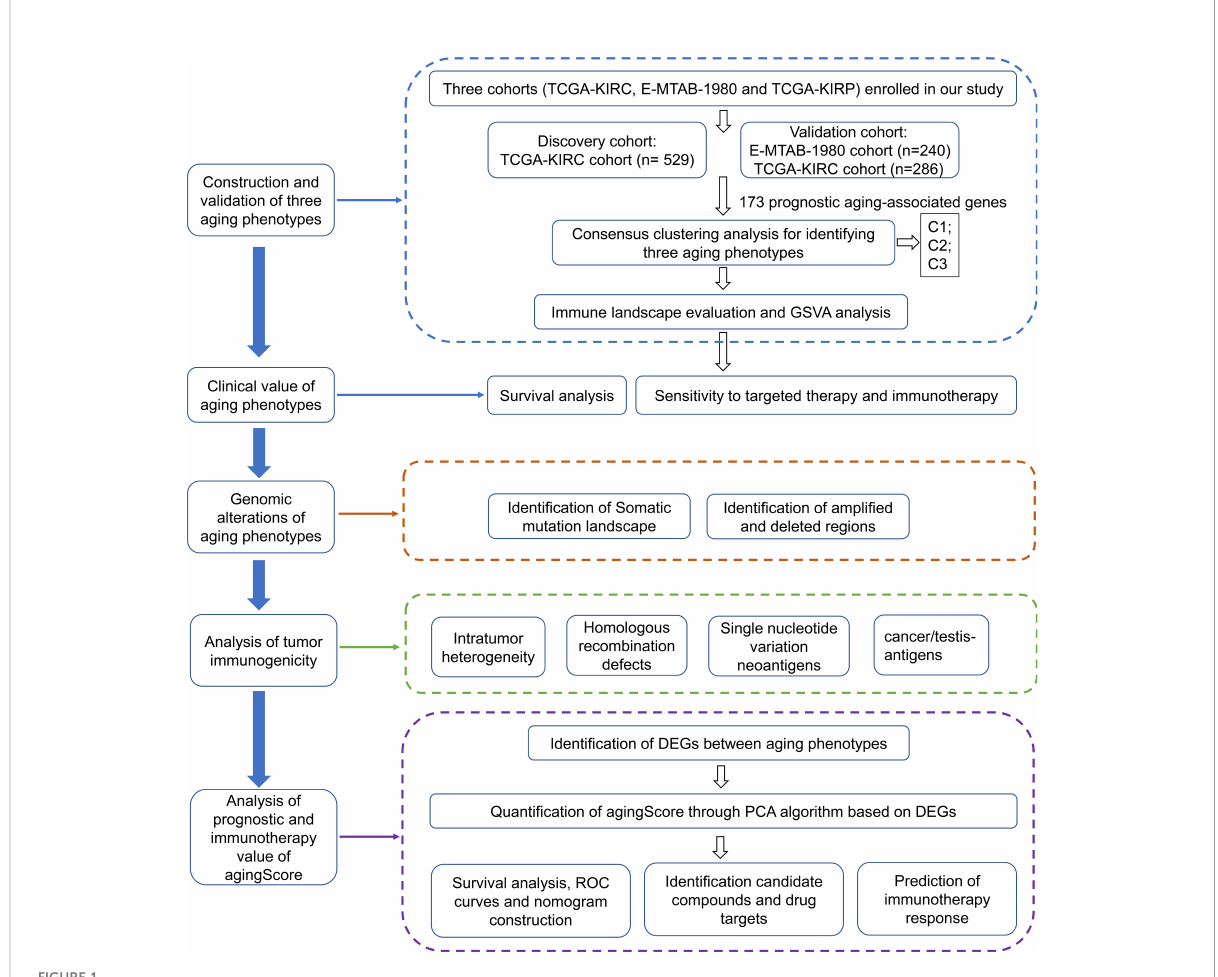
FIGURE 1 The work fl ow of our